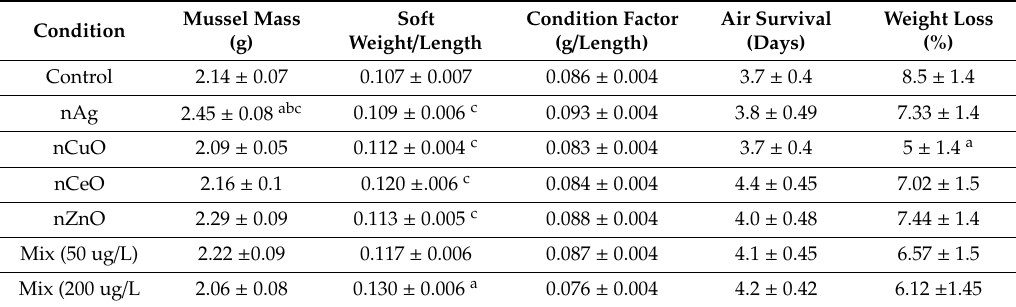
Table 2. Morphological characteristics and air survival time of